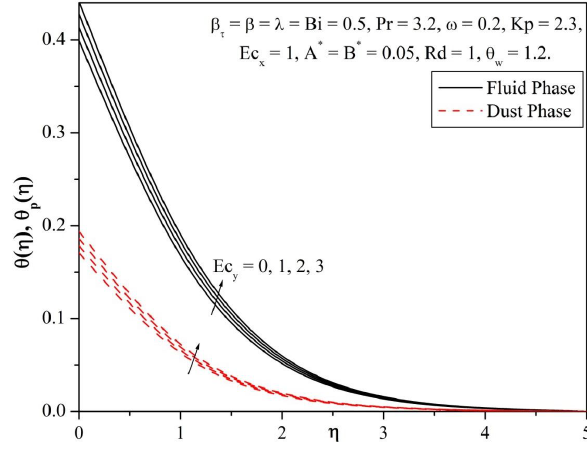
Fig. 12: Dimensionless temperature profiles for different values of β .